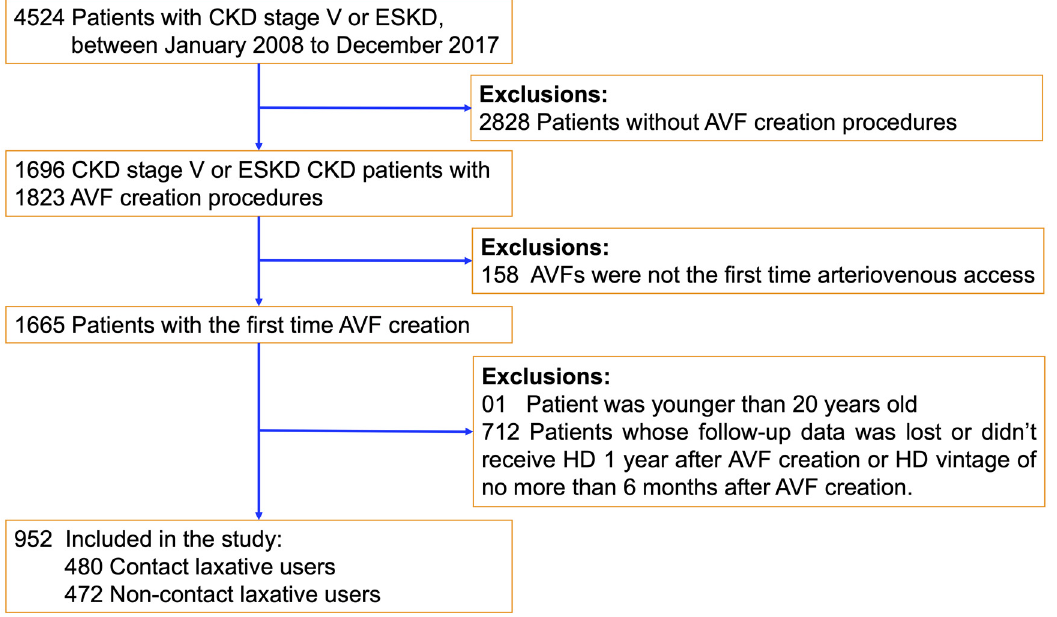
Figure 1. Enrollment process of the study population. Note: CKD—chronic kidney disease; ESKD— end-stage kidney disease; AVF—arteriovenous fistula;